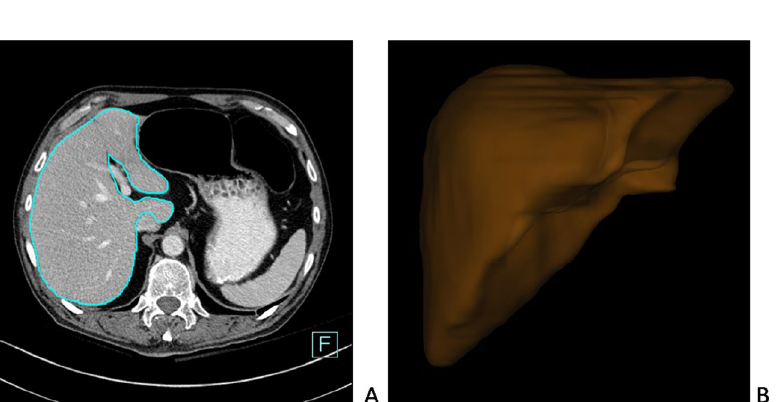
Figure 2. Representative measurement of maximum diameters in CT. Measurements were taken in the three standard dimensions ( A ) mediolateral (CTmaxML) + craniocaudal (CTmaxCC) and ( B ) dorsoventral (CTmaxDV).